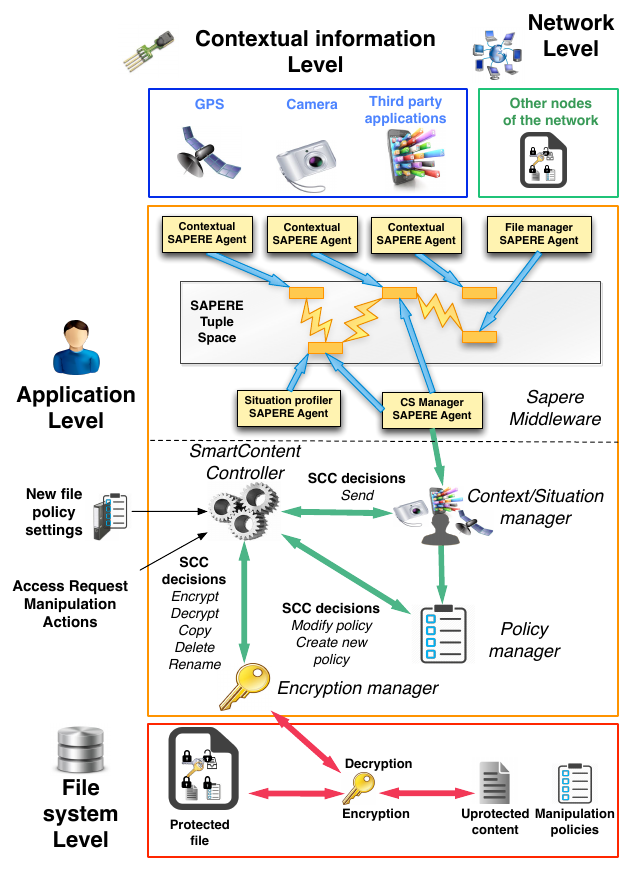
Figure 5. Architecture of an application managing SmartContent